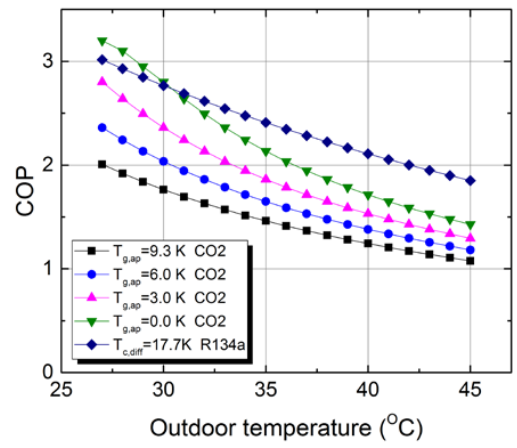
Figure 8. Effect of gas cooler approach temperature on the COP of the CO 2 system.